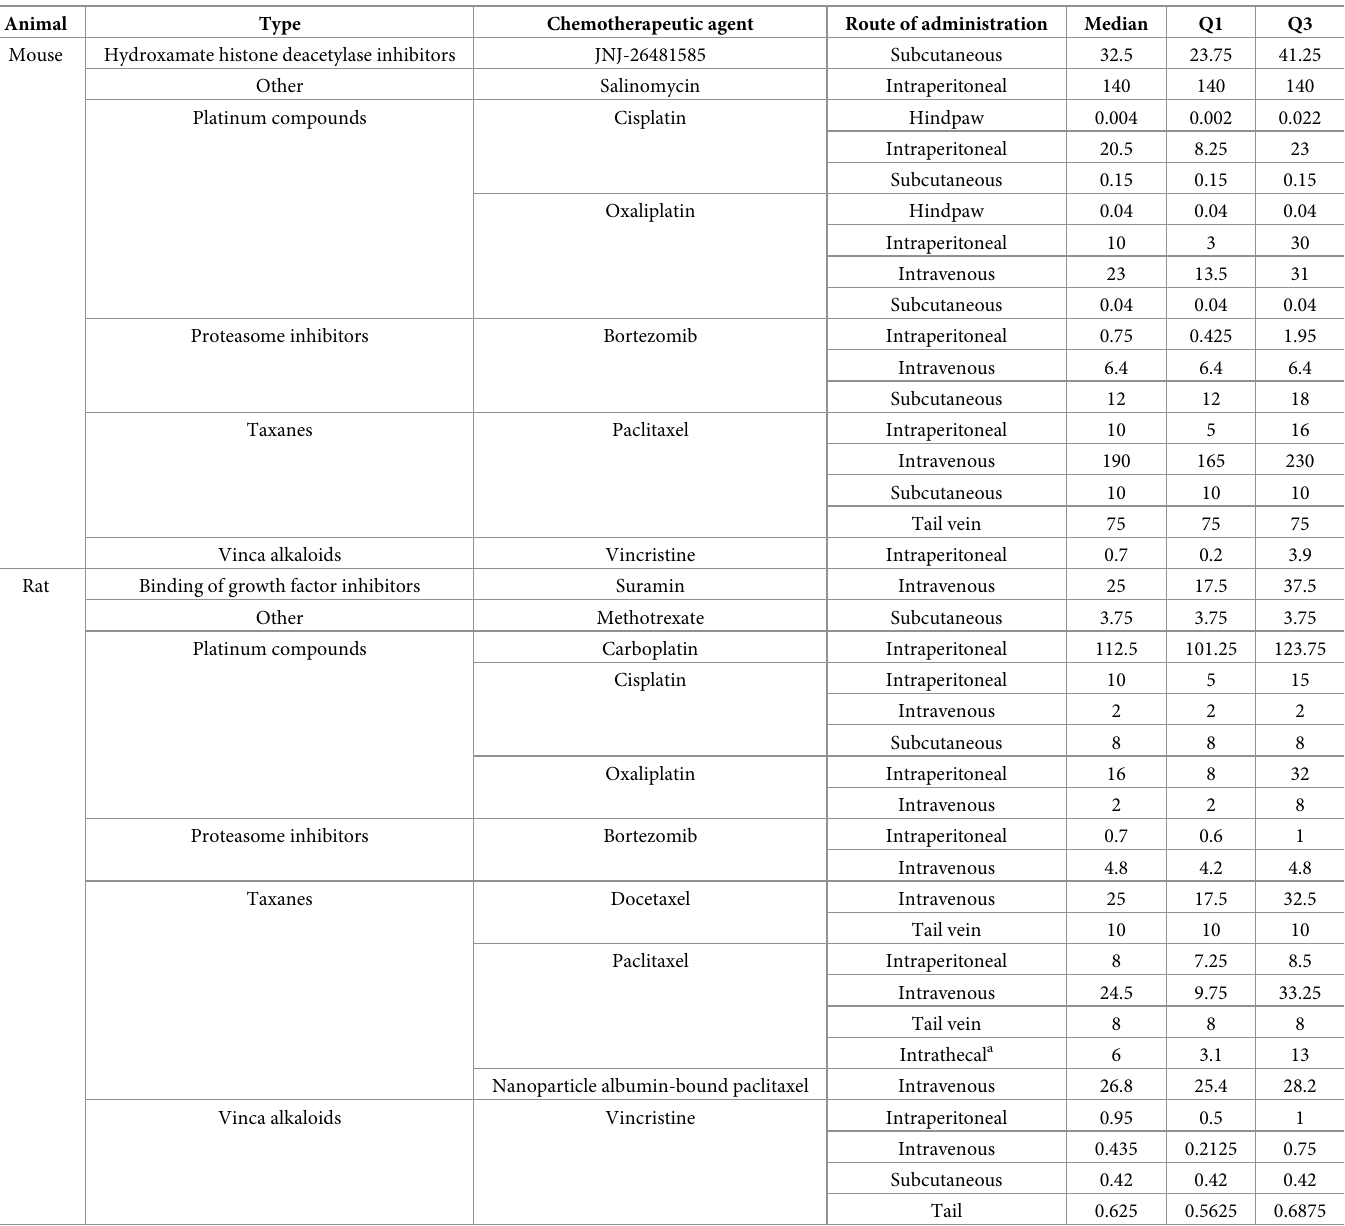
Table 4. Model details including chemotherapeutic agents, route of administration, median cumulative dose, and upper and lower quartiles (data set 1a).